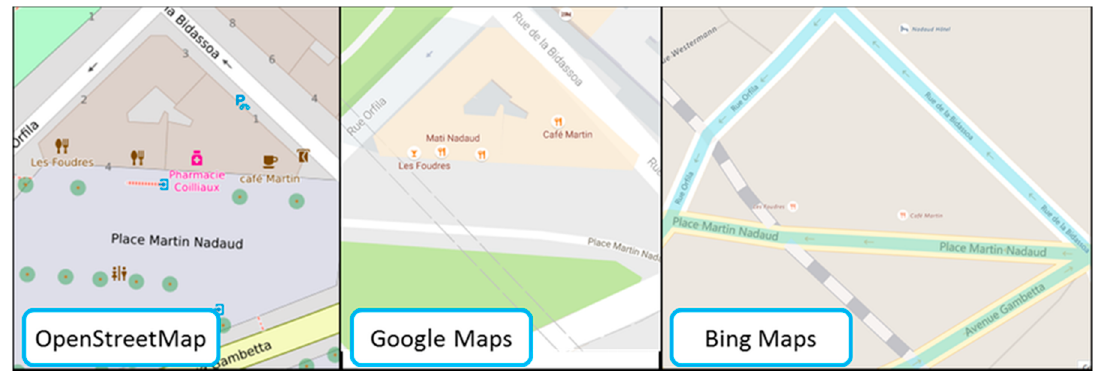
Figure 3. Three maps where the POIs are located differently inside the buildings that host them.